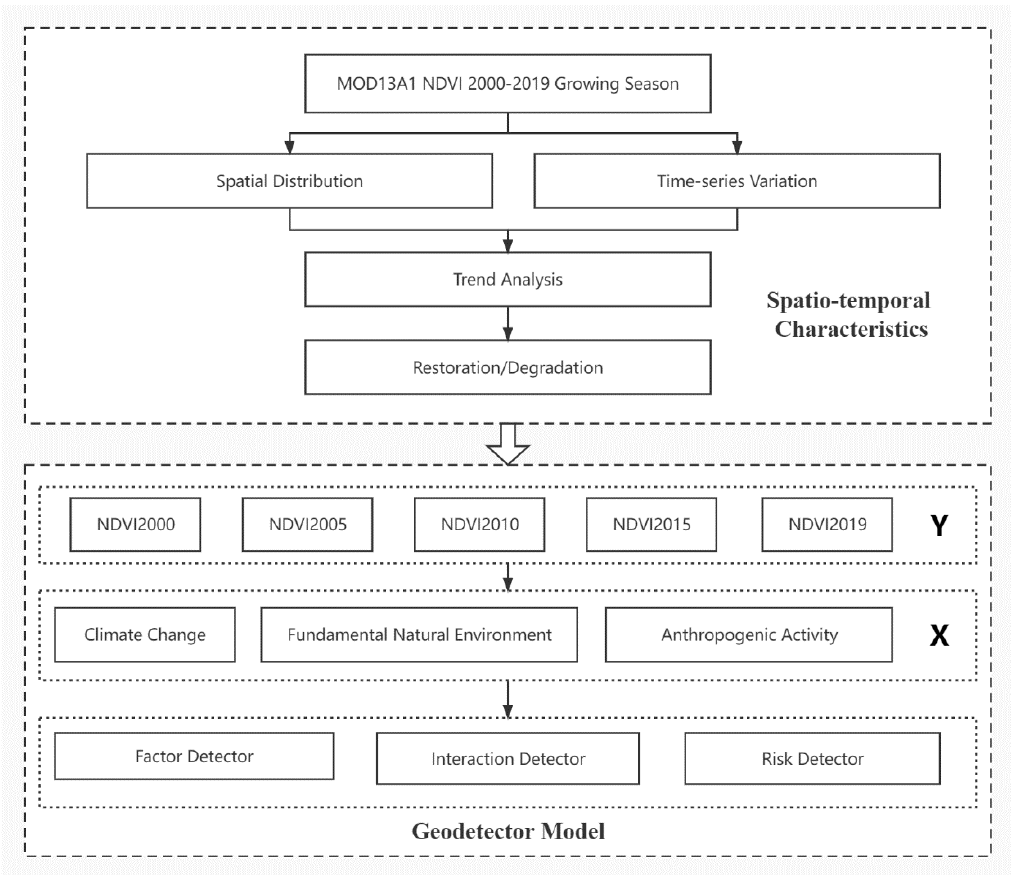
Figure 2. Workflow of spatio-temporal variation and main driving factors in the Xinlingol grass- land.